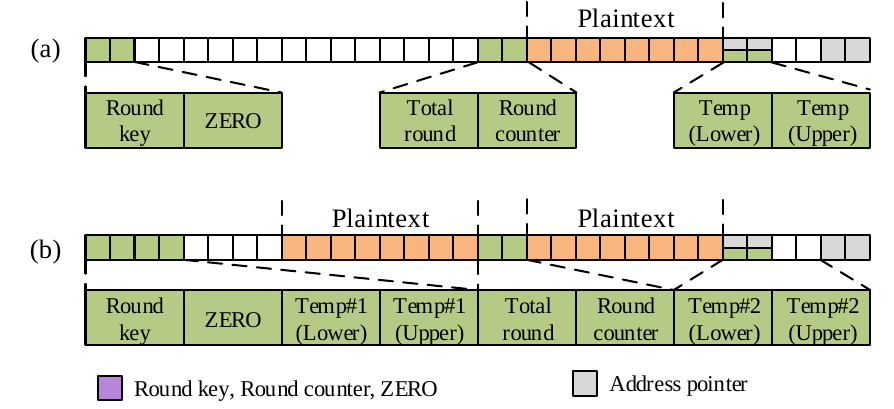
Figure 5. Register alignment for ( a ) separated model and ( b ) pre-computation in online implementations. Each block represents one register. Two colors in one register is used for multiple purposes. Algorithm 1: Separated version for variable-key